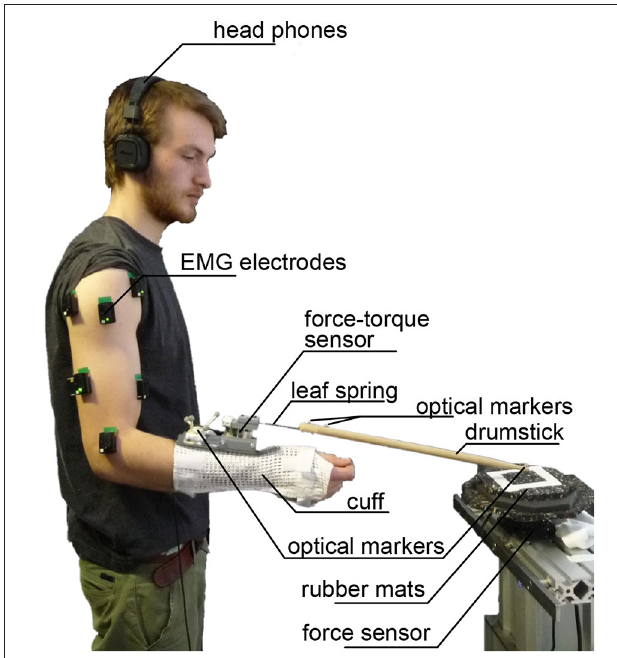
FIGURE 3 | Experimental Setup— Subjects were equipped with a cuff with the attached drumstick, electrodes for measuring muscular activity of respective muscles, as well as markers for optical tracking. Force-torque sensors were placed between drumstick and cuff as well as on the drumming plate. Subjects were given head phones with a metronome beat with the desired drumming frequency. This picture shows one of the researchers and co-authors of this study, who has provided written informed consent to this publication of his image.